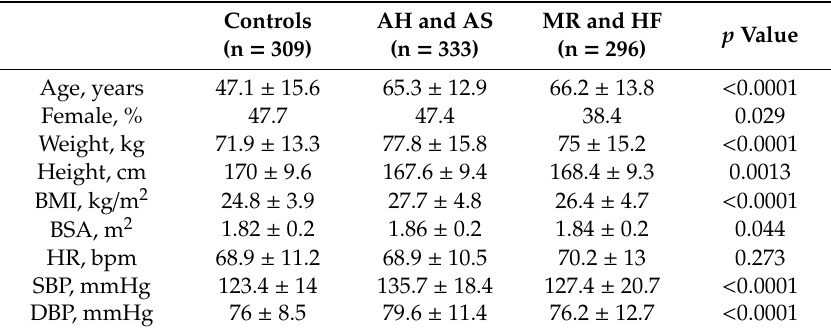
Table 1. Demographic and clinical characteristics.